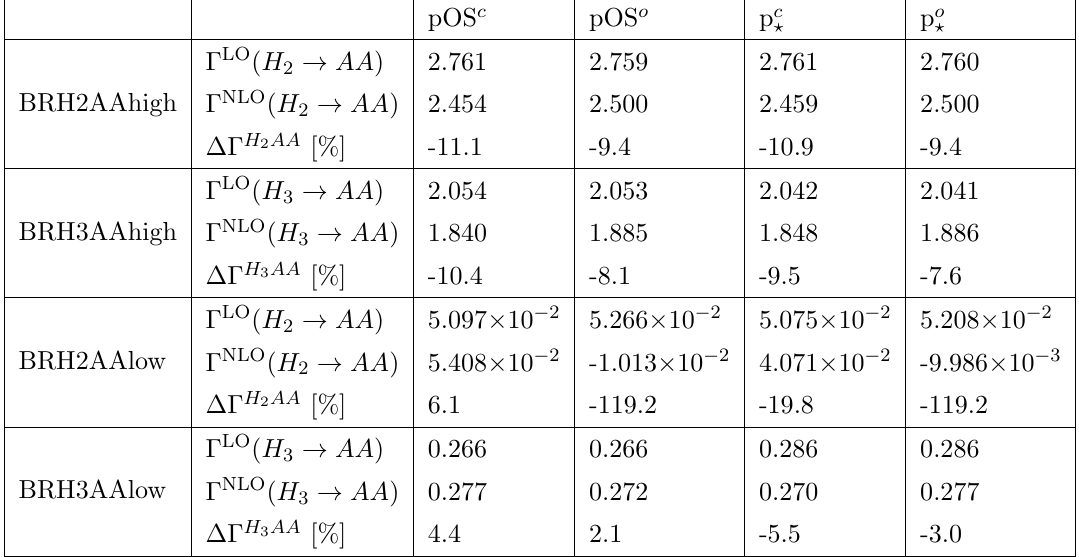
Table 9 . Higgs decay widths (in GeV) at LO and NLO EW accuracy as well as the relative corrections for the N2HDM benchmarks presented in table 8 and four di(cid:11)erent renormalization schemes. The renormalization scale of m 2 is set to (cid:22) R = 2 m A 12